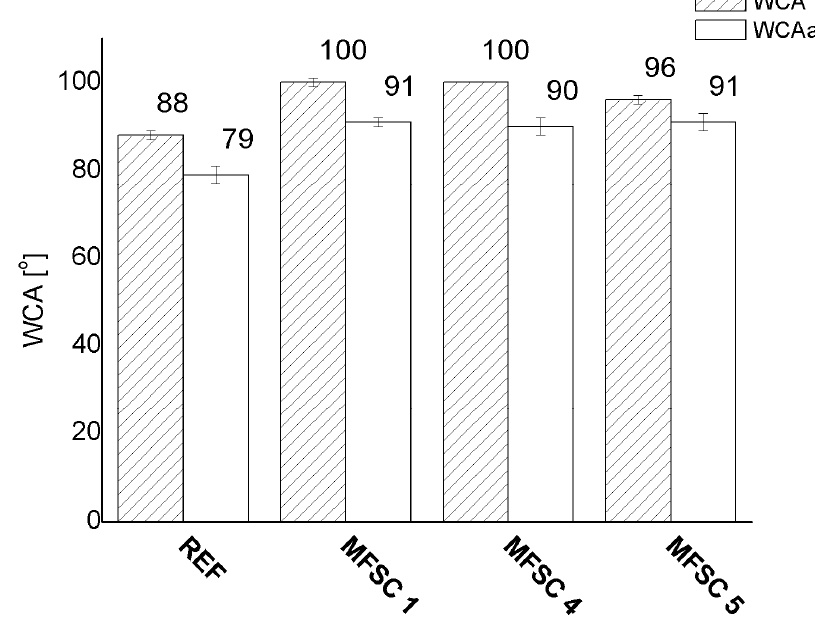
Figure 4. The comparison of water contact angle before and after exposure in an aging chamber. The sample modified with polysiloxane MFSC 5 obtained the lowest decrease in the WCA value among the samples modified with polysiloxanes; the difference between the WCA values was 5%. This sample exhibited one of the lowest IAa results after aging and was one of two samples with the lowest IAa value after aging compared to the reference sample.